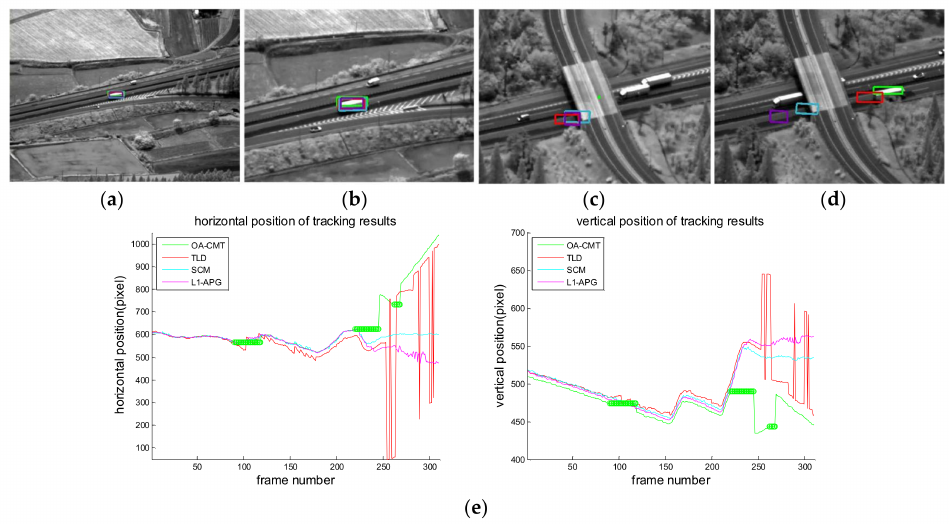
Figure 21. Computer simulation result of imagery ID 6. ( a ) normal tracking status (original image); ( b ) magnifying interested area; ( c ) OA-CMT turns to memory tracking status while the bus is hidden by